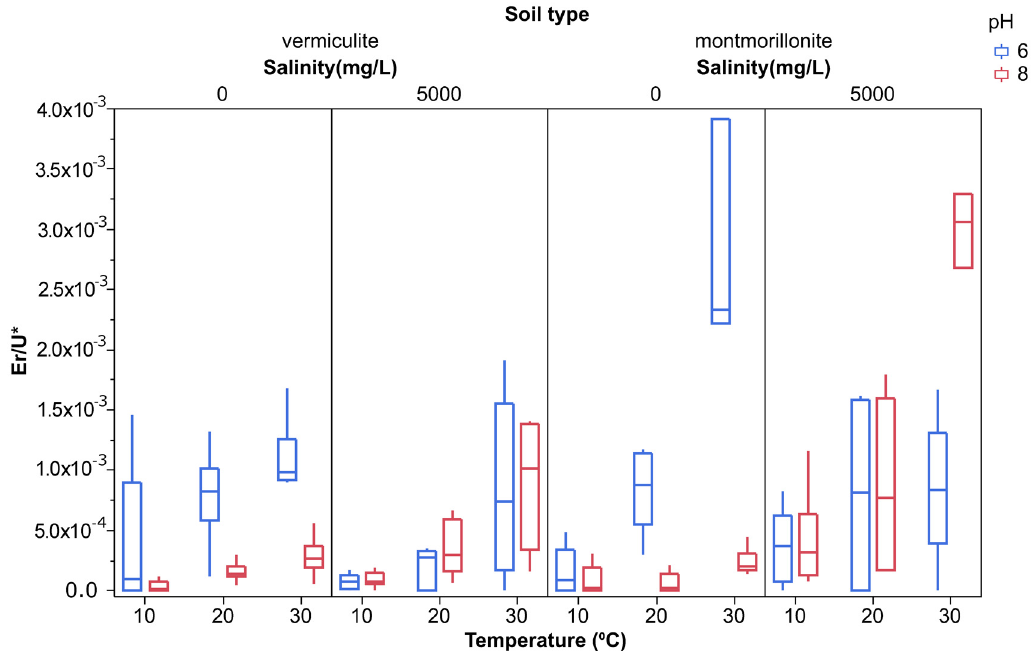
Figure 3. Effect of changing temperature, pH, and rock salt concentration on dimensionless erosion rates (Er/u*) for natural soils dominated by vermiculite and montmorillonite clay minerals. The box shows the interquartile range with the median. The vertical lines indicate the range of the data.